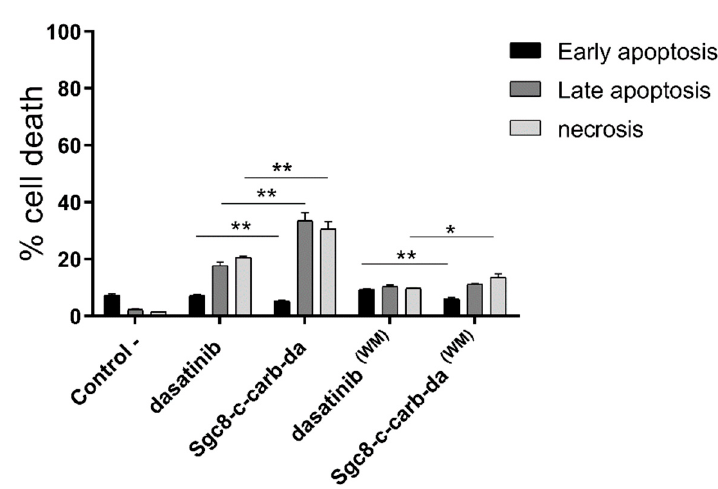
Figure 4. Percentage of cell death of A20 cells obtained after incubation with 800 nM dasatinib or Sgc8-c-cab-da for 24 h, with (WM) or without the washing method (60 min of drug exposure followed by a wash and further incubation). Graph shows mean ± SD, n = 3 per condition. * p < 0.05, ** p < 0.01 (Student’s t -test).